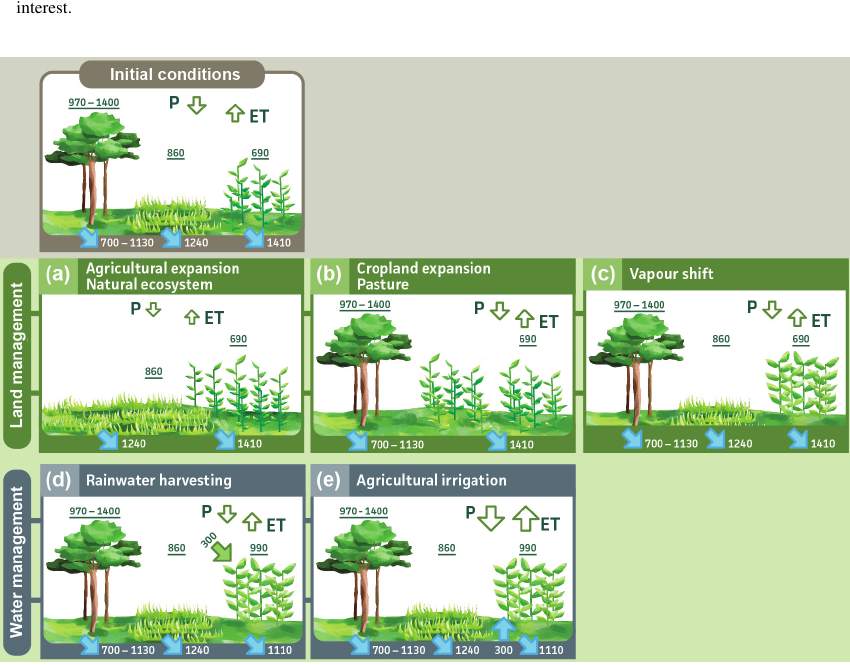
Figure 3. Graphical representation of land and water management options listed in Table 3, with values representing typical evapotranspira- tion (underlined numbers, mmyr − 1 ) and runoff (blue arrows pointing downwards, mmyr − 1 ) assuming 2000mmyr − 1 of precipitation. The downward-facing green arrow (box D) and upward-facing blue arrow (box E) represent 300mmyr − 1 of rainwater harvesting and irrigation